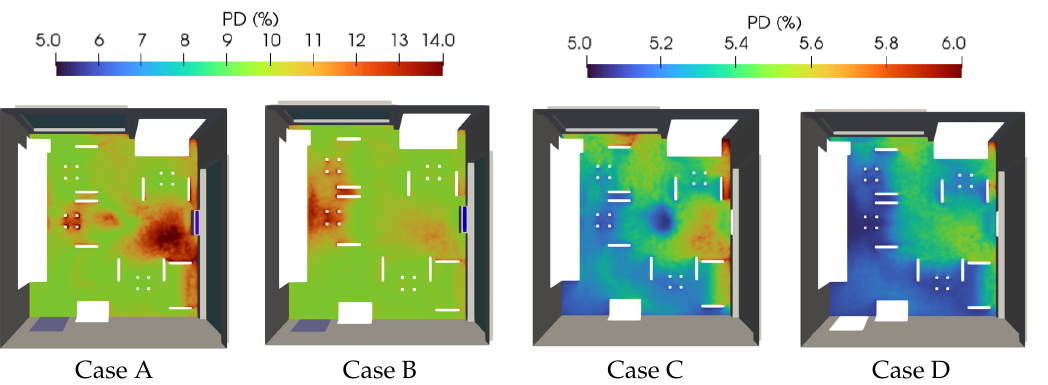
Figure 11. Summer cooling conditions. Percentage of dissatisfied distribution along the office floor obtained for low input air velocity and no solar load (Case A), high input air velocity and no solar load (Case B), low input air velocity and solar load (Case C), high input air velocity and solar load (Case D).